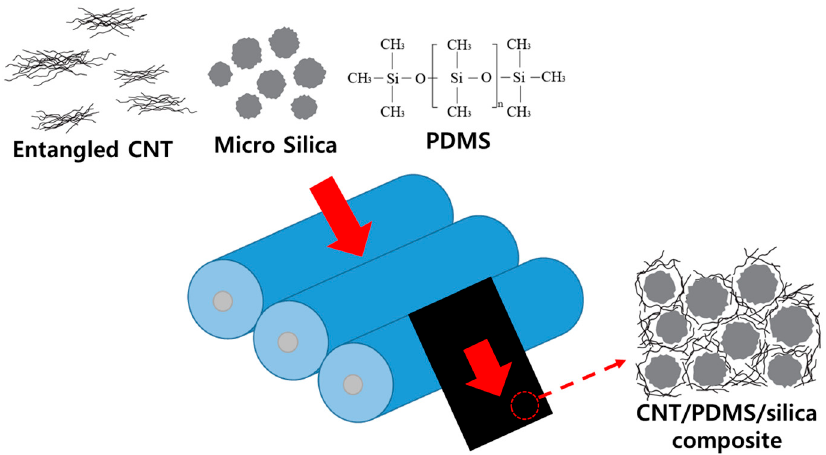
Figure 3. Scheme for the dispersion of highly loaded composites of CNT (carbon nanotube), silica, and PDMS (Polydimethylsiloxane) by three-roll milling. A high shear strain by the three rotating rollers disentangles the CNT and micro-silica.